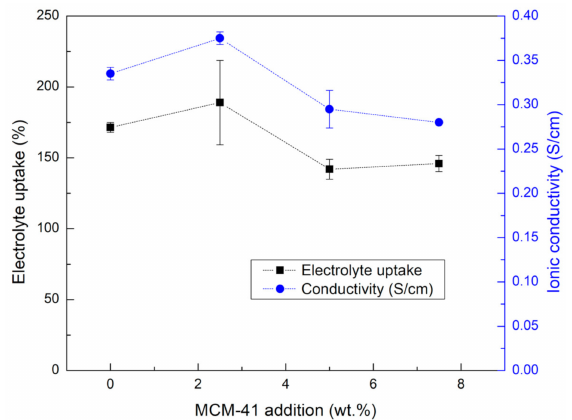
Figure 2. The electrolyte uptake and ionic conductivity of a composite MCM-41 / PVA membrane with di ff erent amounts of MCM-41 loading.